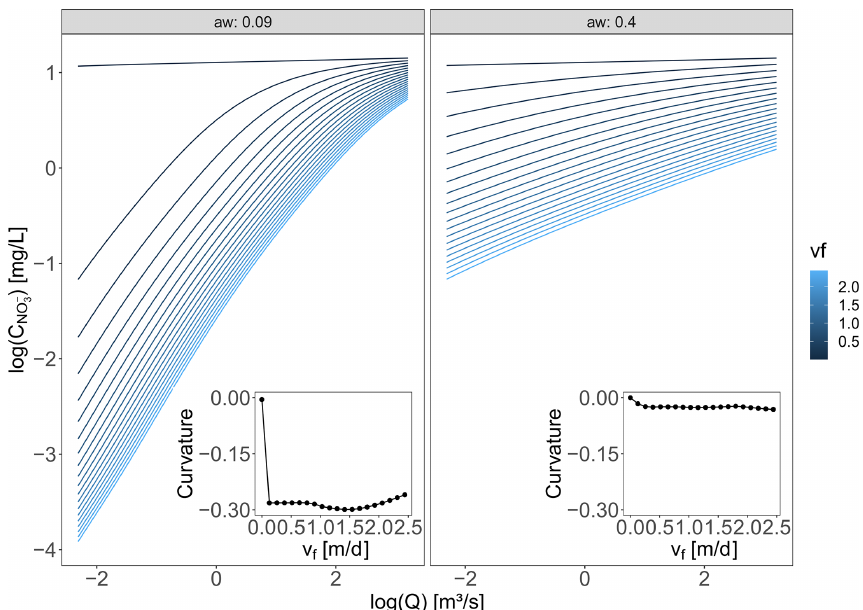
Figure B6. Log (C) –log (Q) relationships and Curv max for increasing uptake velocities ( v f ) resulting from network model simulations of the Selke Meisdorf catchment. As an example, two different a w values are displayed, and v f is varied from almost 0 to 2.5md − 1 with the other parameter values as stated in Table